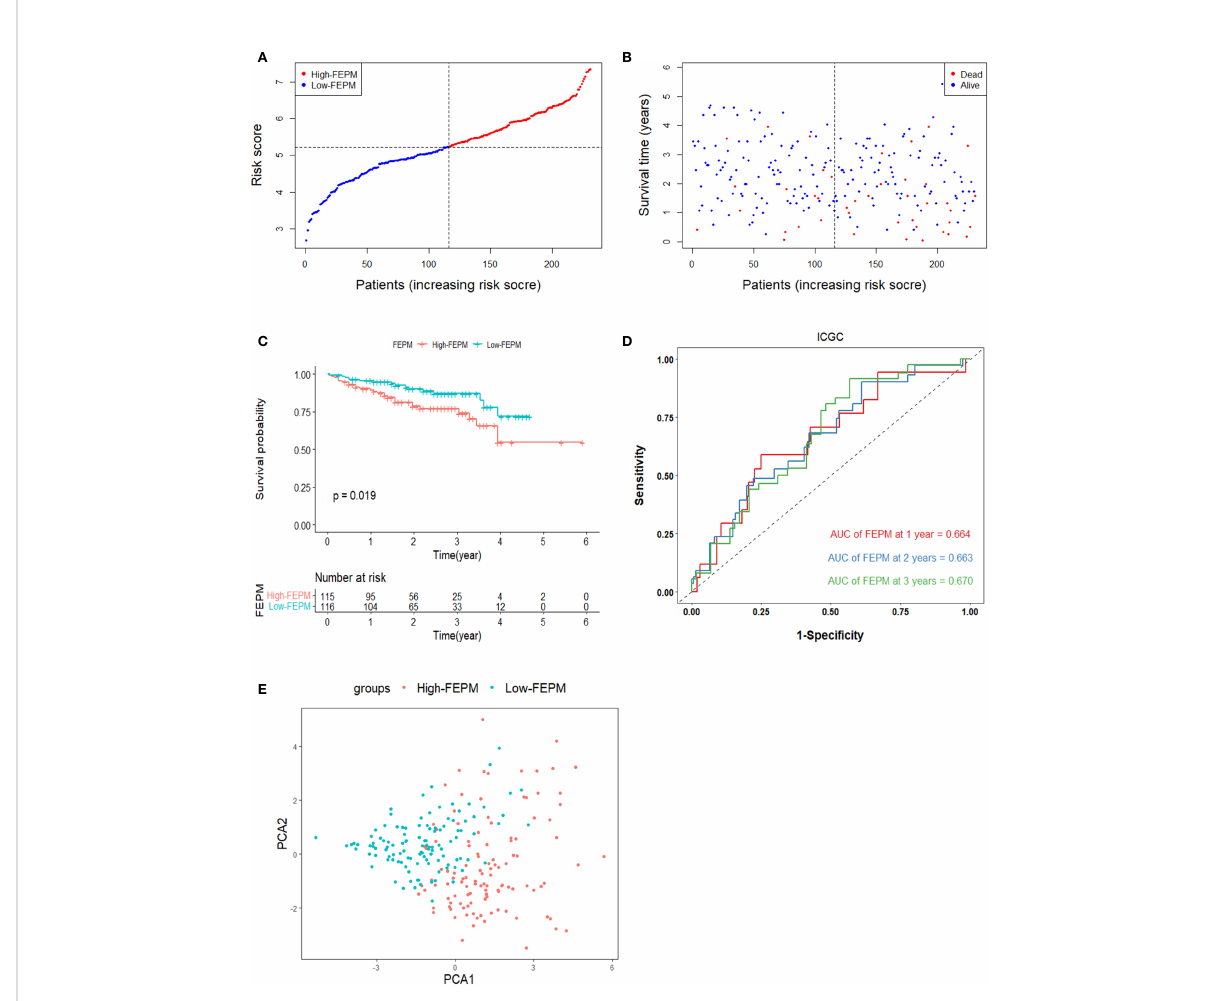
FIGURE 4 Survival analysis of FEPM in the ICGC cohort. (A, B) Distributions of FEPM scores and survival status of HCC patients in the ICGC cohort. (C) Kaplan – Meier curves showed that patients in the high-FEPM group had worse prognosis than those in the low-FEPM group in the ICGC cohort. (D) ROC curves of FEPM for predicting the 1/2/3-years survival in the ICGC cohort. (E) PCA plots of the ICGC cohort based on